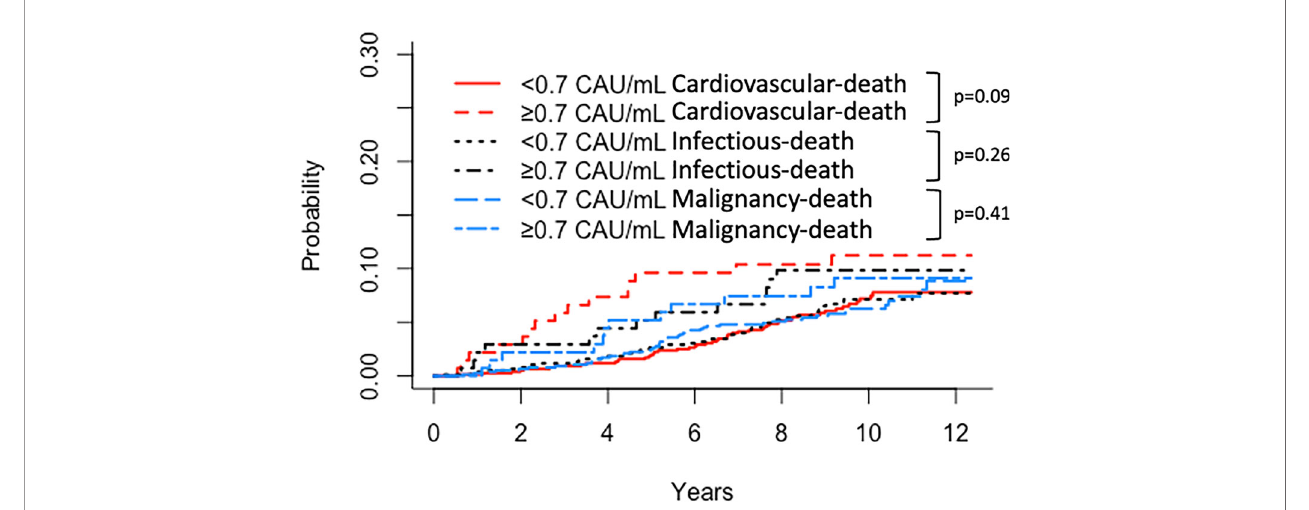
FIGURE 5 | Kaplan – Meier estimates of (Red) cardiovascular, (Black) infectious, and (Blue) malignancy patient survival after kidney transplantation according to plasma terminal C5b-9 complement complex (TCC) concentration 10 weeks after transplantation; cut point of <0.7 CAU/ml.